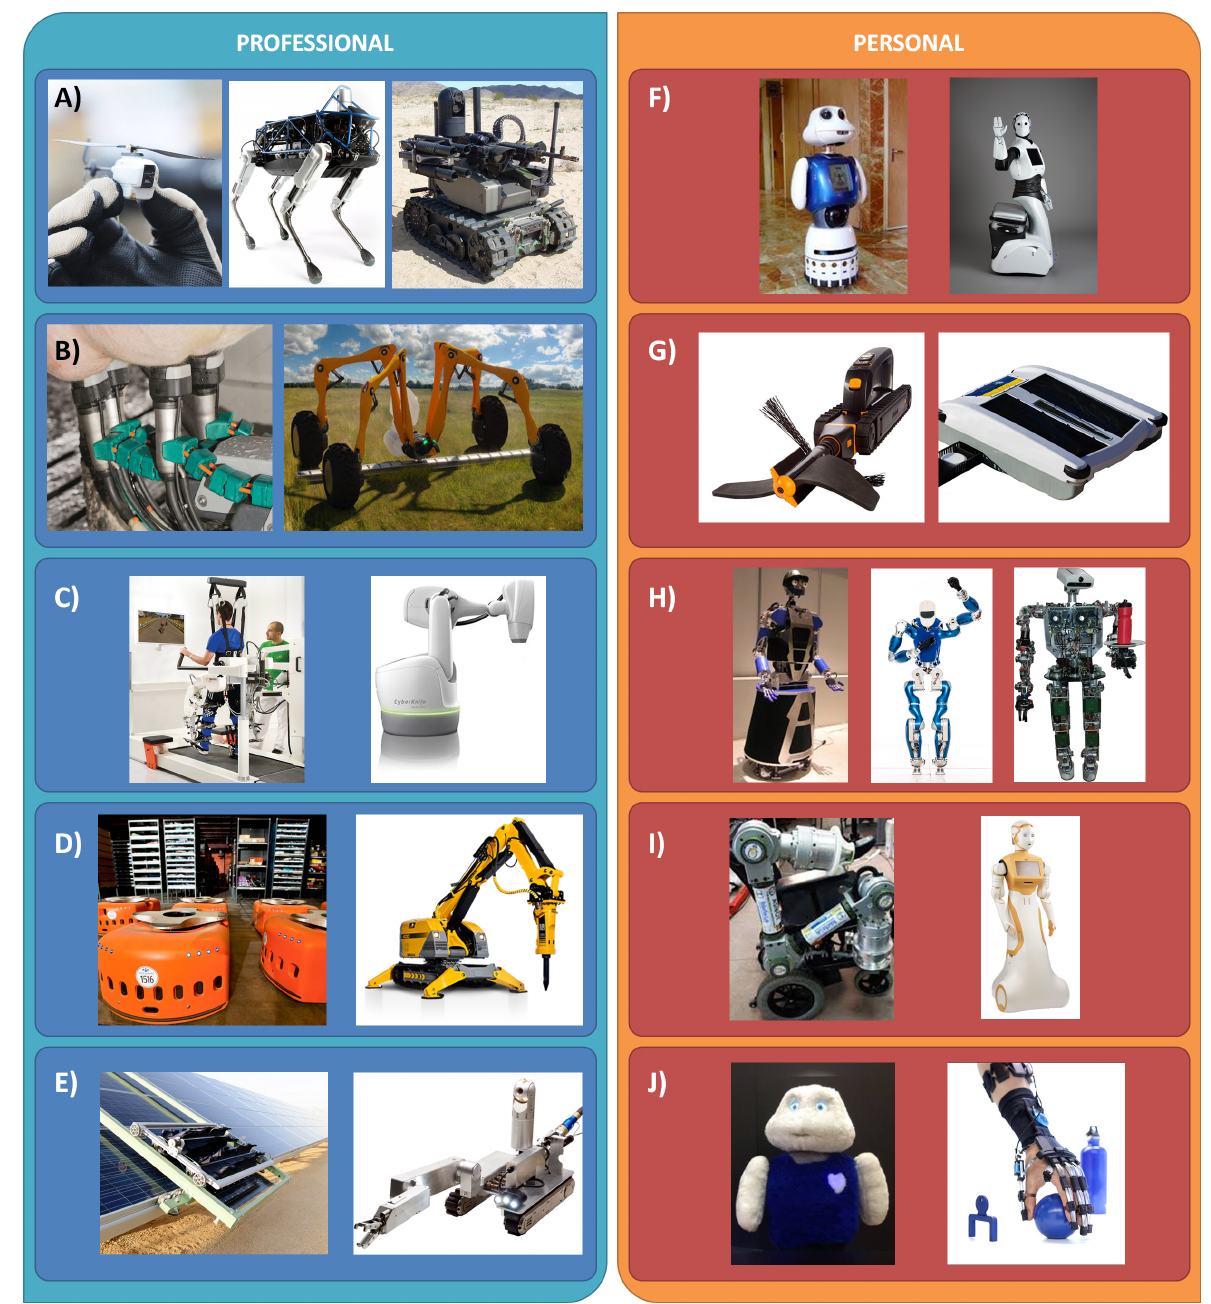
Figure 3. Classification of different service robots ( A – J